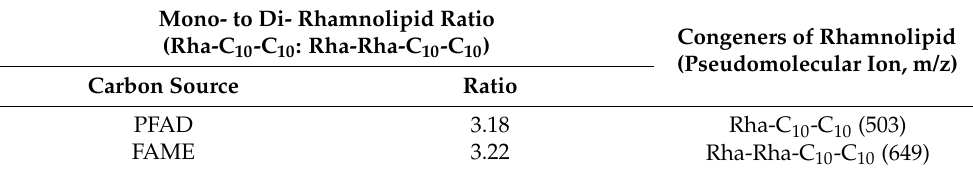
Table 2. The mass spectrometry analysis for the composition of chemical and mono- to di-rhamnolipid ratio of the rhamnolipid mixture produced by P. aeruginosa PAO1. Mono- to Di- Rhamnolipid